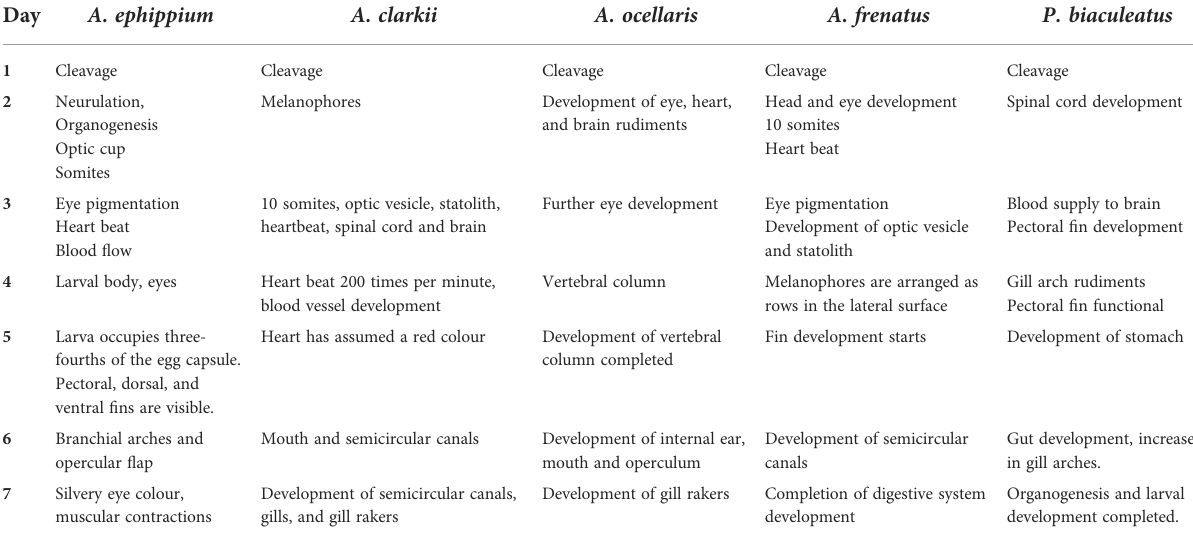
TABLE 4 Embryological changes during egg